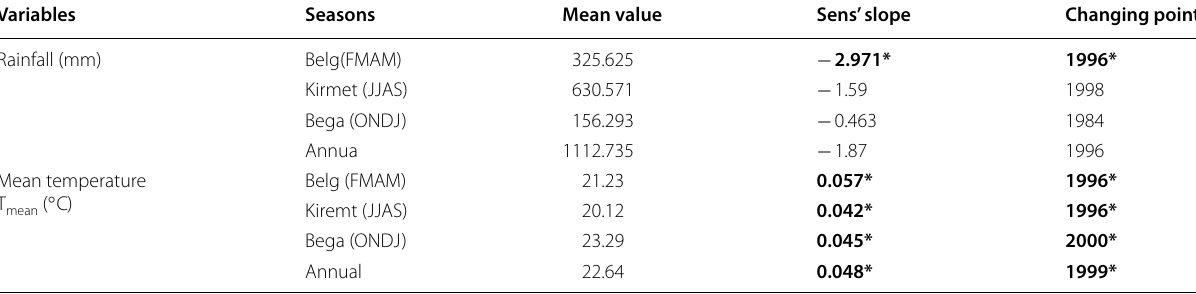
* Bold values represent statistically significant at P < 0.05, rainfall trend (mm/year), and temperature trend (0C/year)